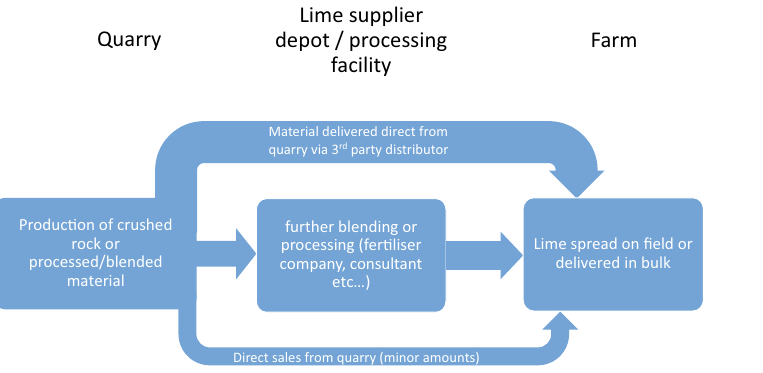
Figure 5. Major flows of agricultural lime in the